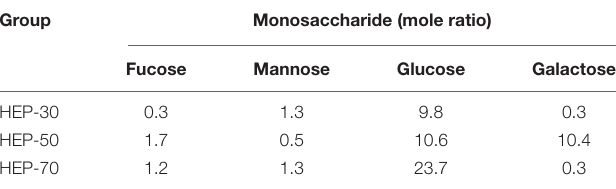
TABLE 2 | Monosaccharide composition of different grades of HEPs. Group Monosaccharide (mole